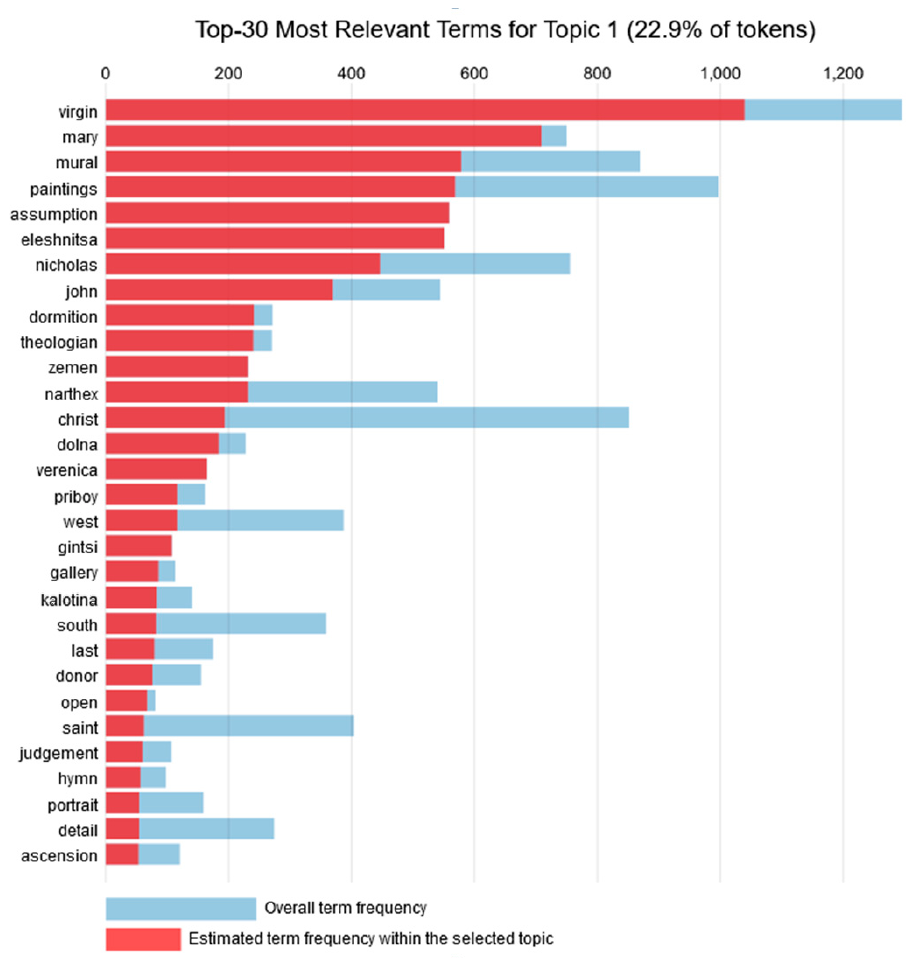
Figure 2. Top-30 most relevant terms for Topic 1.